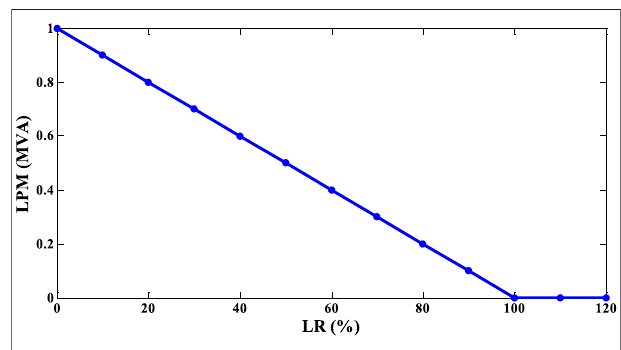
FIGURE 3 | Schematic diagram of the relationship between indicator LPM and indicator LR.